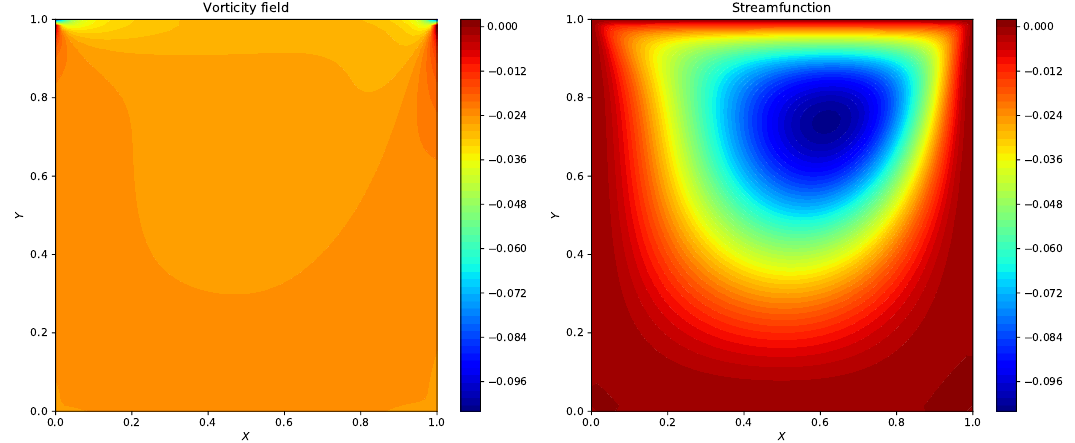
Figure 25. Vorticity field and streamfunction field for the lid-driven cavity benchmark